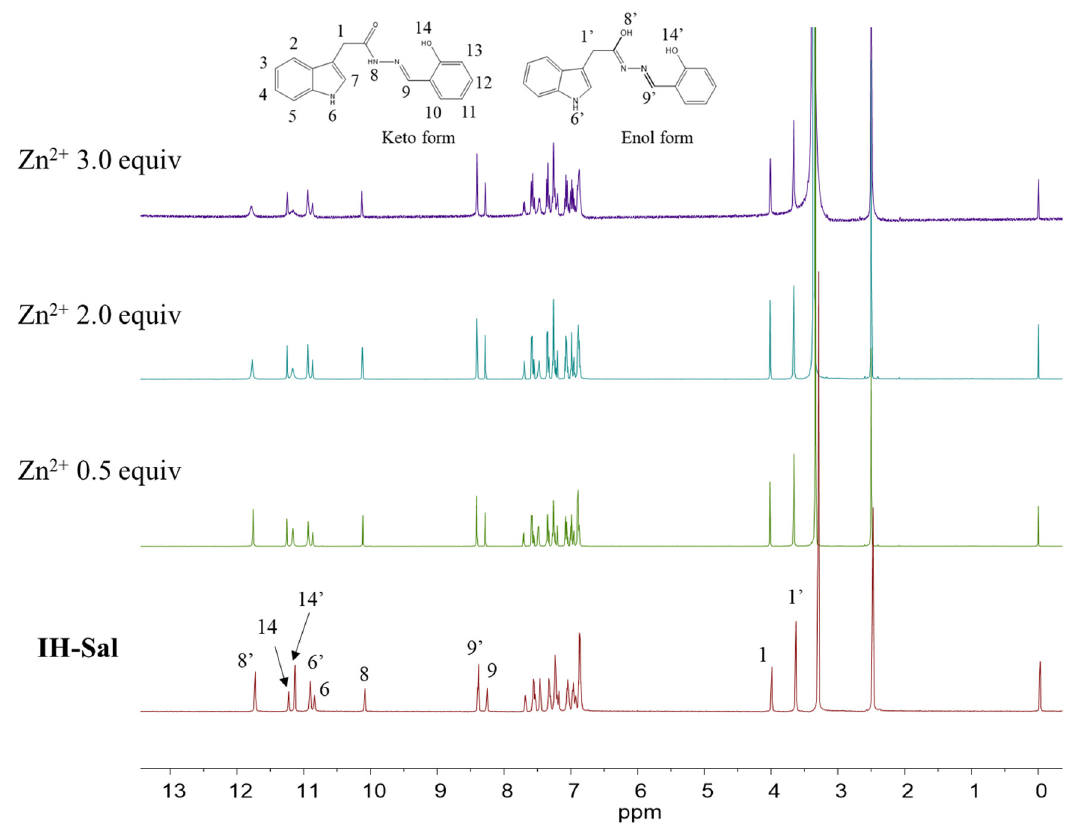
Figure 2. 1 H NMR titration of IH-Sal with Zn 2+ (0, 0.5, 2.0 and 3.0 equiv).